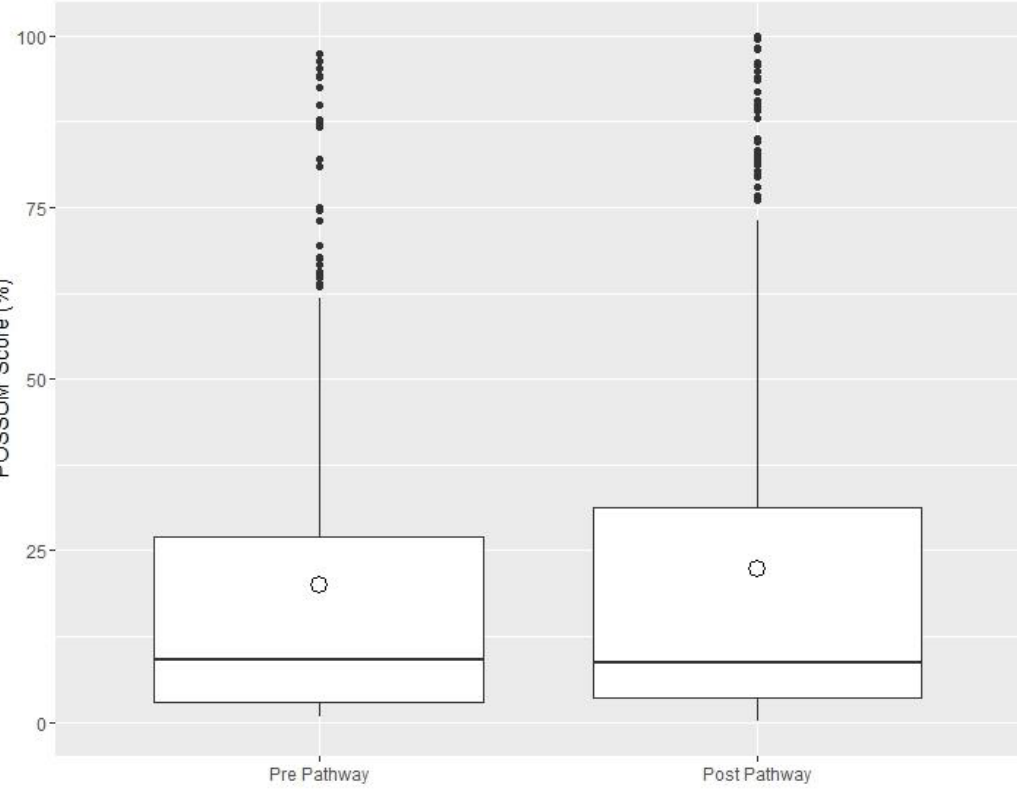
Figure 1. Cumulative P-POSSUM scores pre- and post-ELPQuiC implementation—circle represents the mean value.